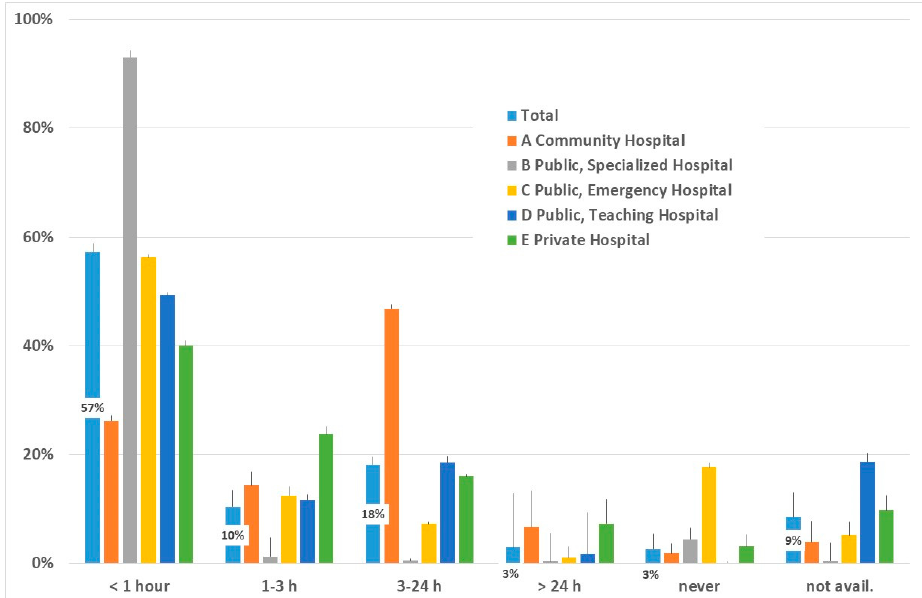
Figure2. Timeofstartofbreastfeedingafterdelivery; percentagesareindicatedforcolumnsrepresenting total results. Vertical lines indicate 95%